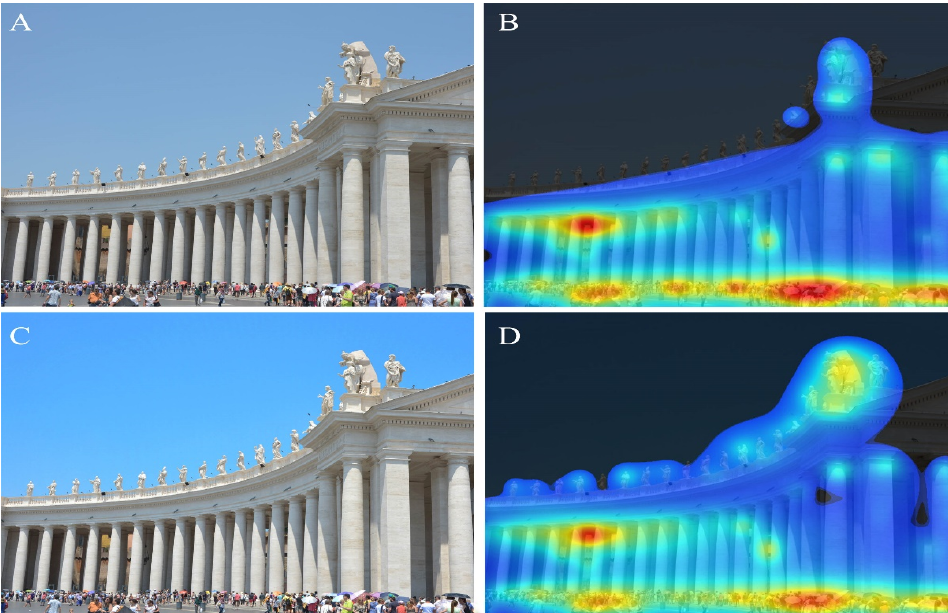
Figure 14. ( A ) Partial view of the colonnade in St Peter’s square, the Vatican, Rome, presented in lower saturation and contrast. ( B ) Eye-tracking simulation heatmap. ( C ) The same image, presented in higher saturation and contrast, with ( D ) improved eye-tracking simulation heatmap.